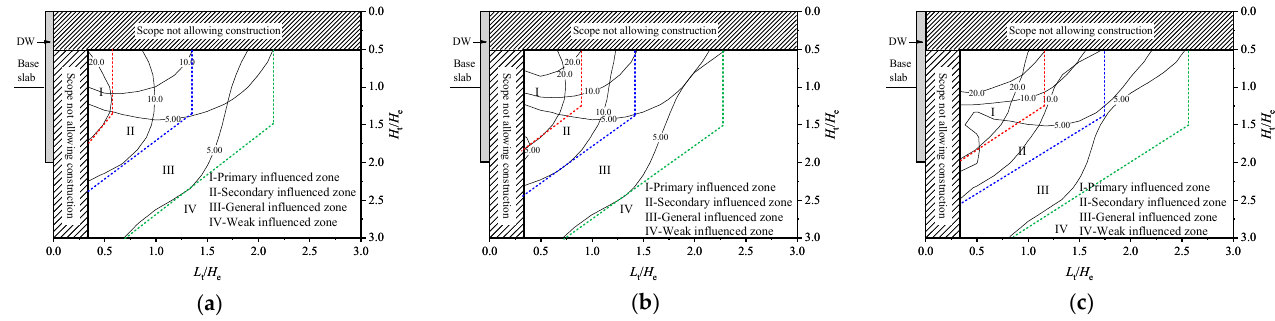
Figure 5. In fl uenced zone of deep excavation on adjacent tunnel displacement ( H e = 18 m): ( a ) δ hm =